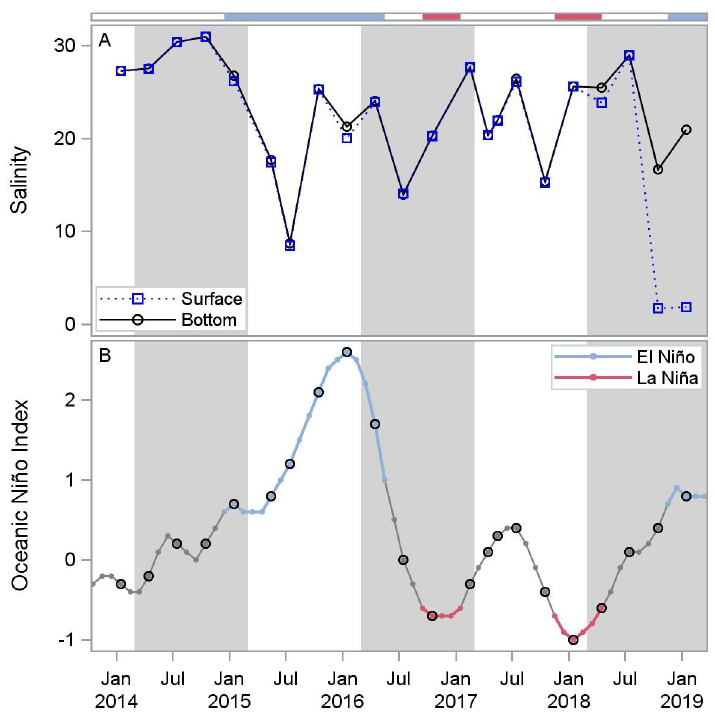
Fig 2. Mean salinity at Half Moon Reef at the surface ( < 1 m depth) and bottom ( > 1 m depth, measured quarterly; A) and Oceanic Ni ñ o Index (ONI; B), measured monthly, from January 2014-January 2019. Large points on ONI graph indicate sampling dates. Colors on ONI graph and horizontal bar indicate ENSO state: light blue = El Ni ñ o, red = La Ni ñ a. ONI data are from [17].